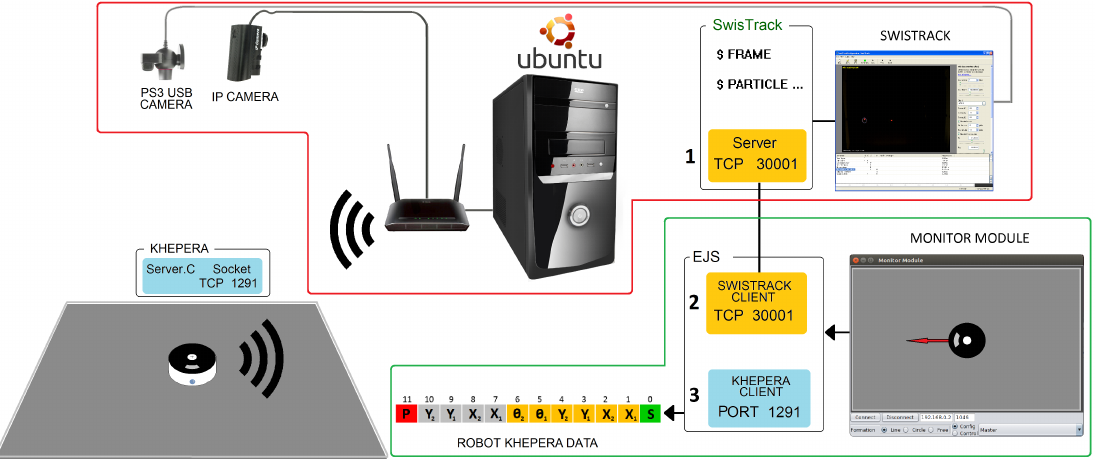
Figure 7. Hardware and software components of the